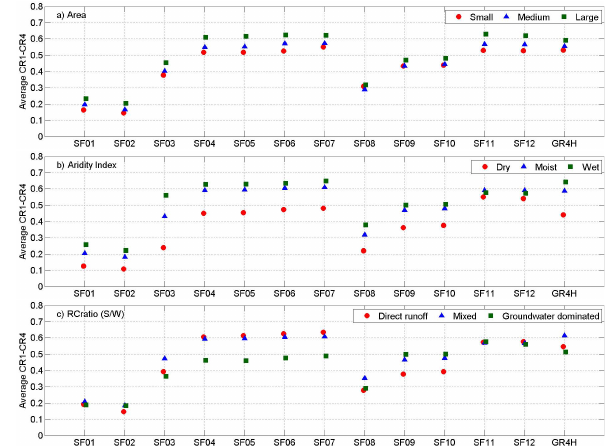
Fig. 4. Average of CR1-CR4 in validation in three classes of: (a) catchment area, (b) aridity index, and (c) RC S/W